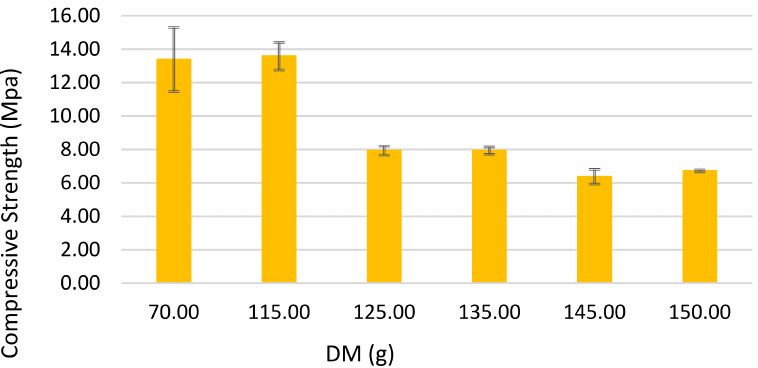
Figure 4. Effect of diabase mud on average 72 h compressive